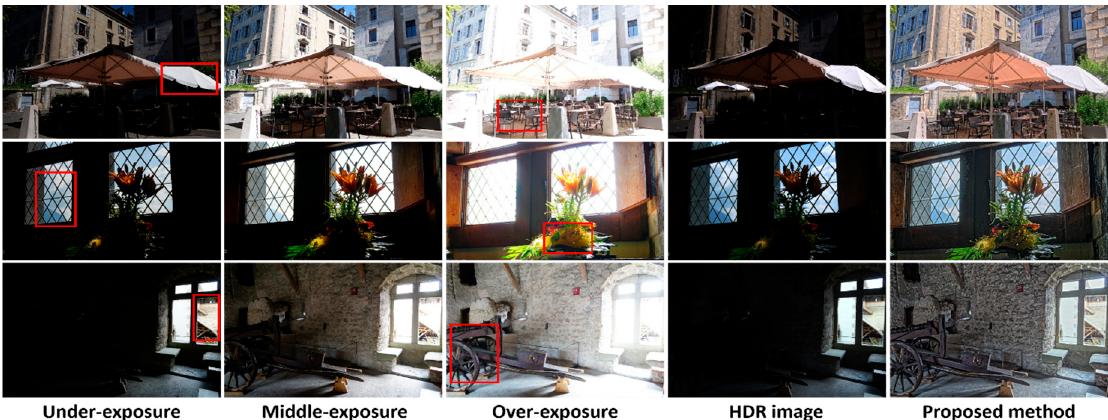
Figure 7. Comparison of multiple-exposure images and the results of our proposed method. The red rectangles indicate the areas which should be closely examined by the reader.